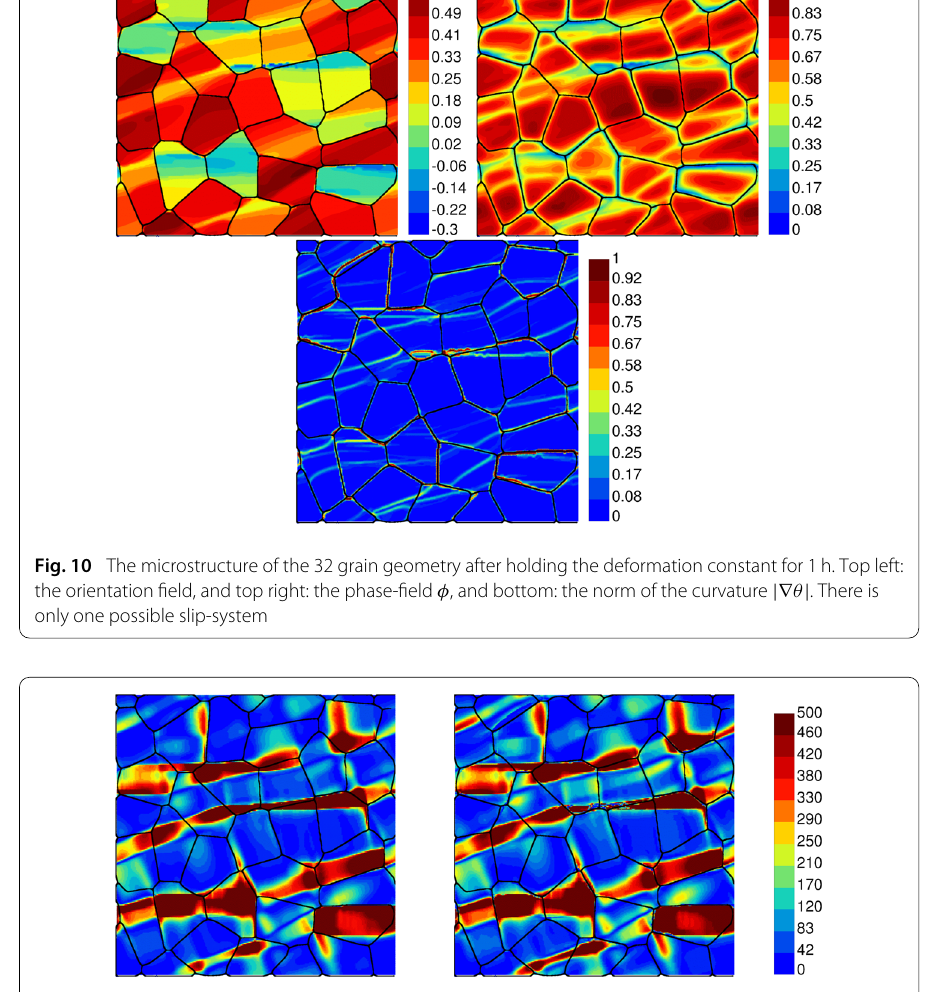
Fig. 11 The dislocation density distribution in the 32 grain microstructure immediately after deformation (left) and after 35min of constant deformation (right). The maximum display value for ρ has been set to 5 · 10 14 m − 2 (the scale of the colorbar is in µ m − 2 ) in order to more clearly demonstrate how it is distributed over the grains. The true maximum value is 1 . 9 · 10 15 m − 2 . There is only one possible slip system in the